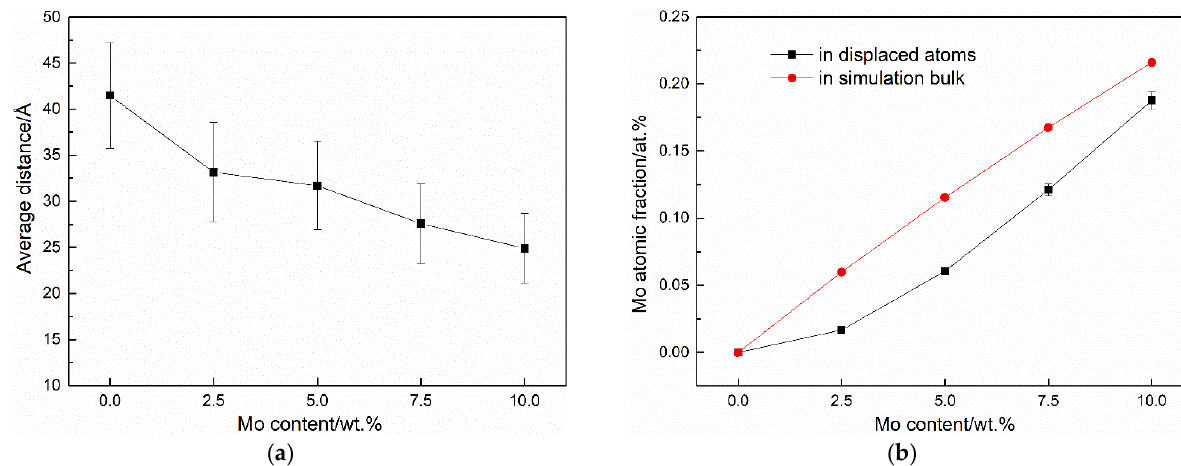
Figure 7. ( a ) Average distances between residual defects and the initial position of PKA as a function of Mo content and ( b ) Average atomic fractions of Mo among atoms with displacement more than 1 Å as a function of Mo content. The corresponding Mo atomic fractions in the total simulation bulk are also shown for comparison.